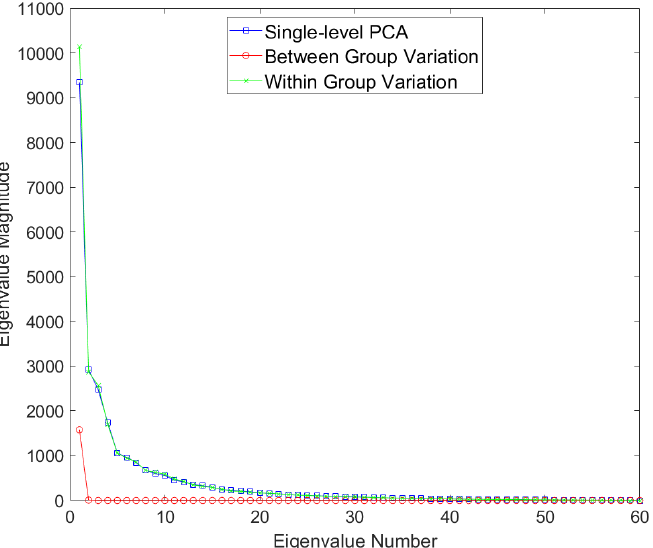
Figure 8. Eigenvalues for single-level PCA and mPCA for between-groups variation (level 1) and within-groups variation (level 2) for the Smile dataset.